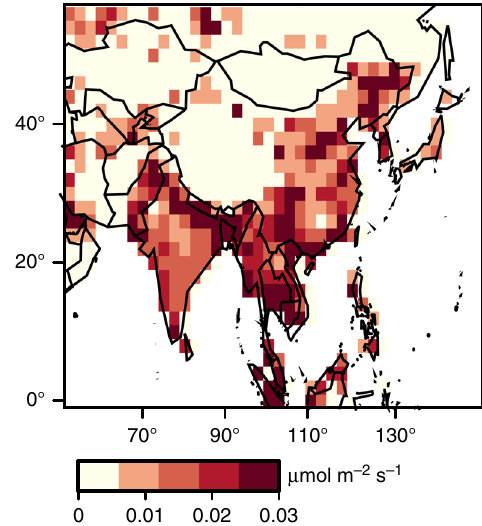
Fig. 3 Map of CH 4 emissions estimates. Total CH 4 emissions (anthropogenic plus natural) estimated using GOSAT observations and the inverse model (2010 – 2015 mean). CH 4 emissions from China are highest in provinces with large coal production and coal formations that contain high amounts of CH 4 (e.g., Shanxi, Guizhou, and Anhui; refer to Supplementary Fig. 1). Note that the inverse modeling emissions estimate is highly uncertain for any individual grid box, but those uncertainties decrease at increasing spatial scales (Supplementary Fig.